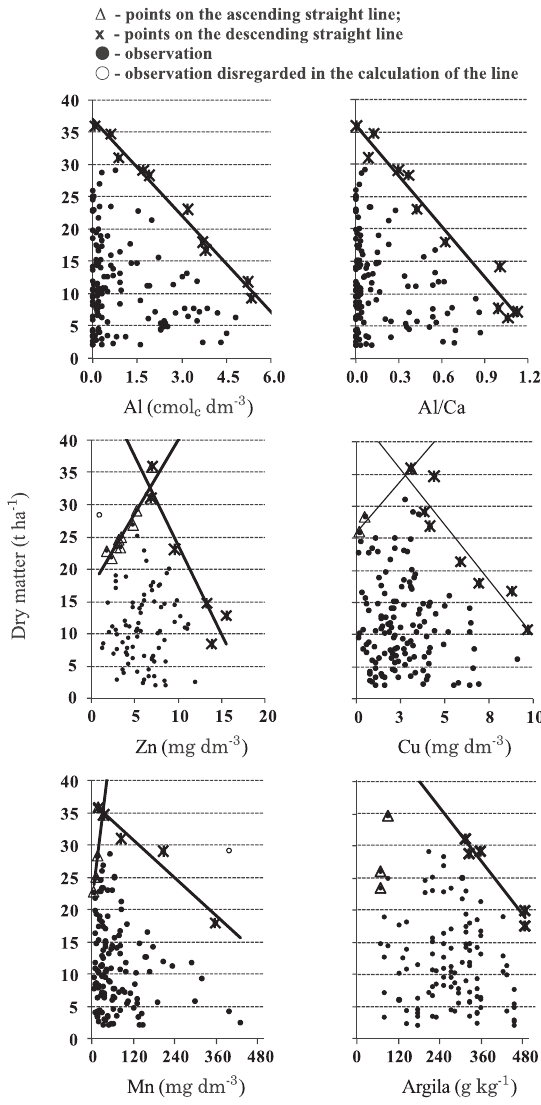
figure 3. Relationship between the yields of Salix x rubens and exchangeable contents of al, Zn, cu, and mn and clay in the soil on the Southern Plateau of Santa catarina, total observations: